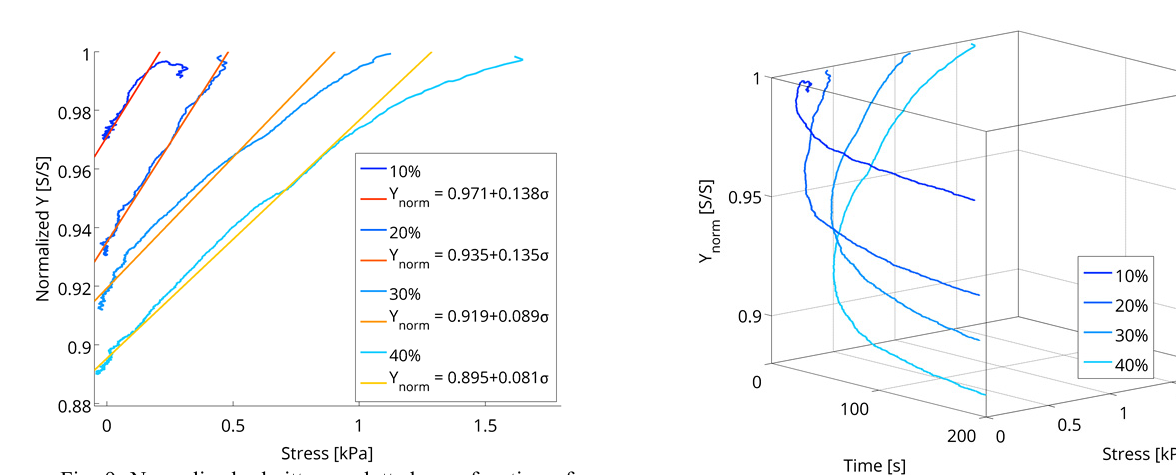
Fig. 9. Normalized admittance plotted as a function of stress and linear regression fit for each strain level. Also presented are the equations of the fit data.